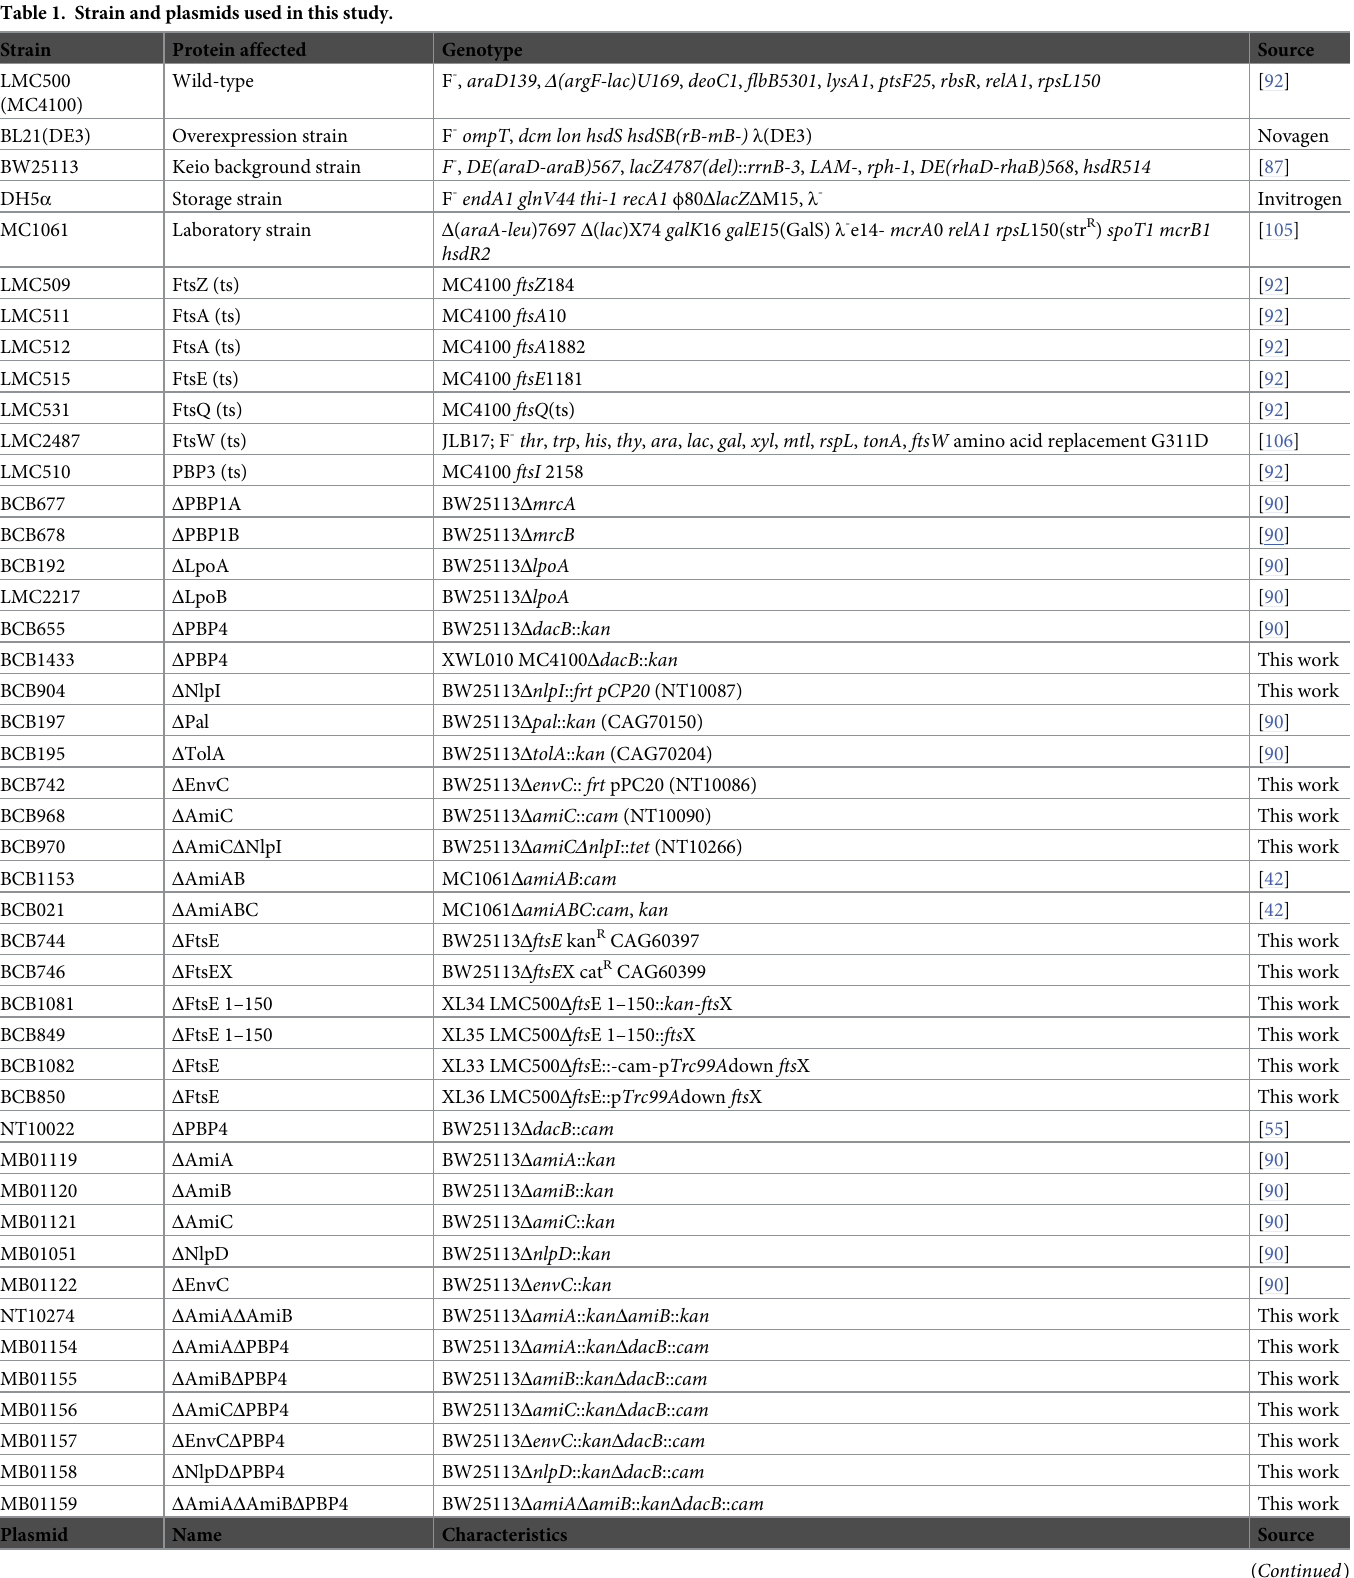
Table 1. Strain and plasmids used in this